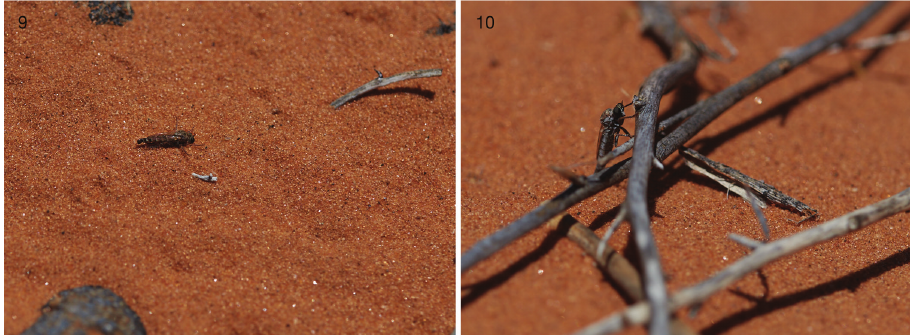
Figures 9–10. Photographs of M. gaiophanes sp. n. in nature on sand dune as in Figs 1–2: 9 ♂ resting on sand (note that pro-, mes- and metathoracic legs are held sideways and up so that tarsi do not touch sand, Mor- phbank #861774) 10 ♀ resting on dry vegetation just above ground (#861777). Photographs by T. Thorax : brown, postpronotal lobes and lateral scutum orange to light brown; pros- ternum grey pubescent, separated from proepisternum, square to rectangular in shape (straight dorsally); proepisternum grey pubescent, long yellowish macrosetose; cervical sclerite long yellowish setose; antepronotum grey pubescent, short yellowish setose and long yellowish macrosetose; postpronotum grey pubescent, long yellowish macrose- tose medially and laterally, long yellowish setose sub-laterally; postpronotal lope short and long yellowish macrosetose; pleuron grey pubescent; proepimeron short yellowish macrosetose anteriorly; anepisternum short yellowish macrosetose dorsally, supero- posteriorly short yellowish macrosetose (indistinguishable from other dorsal anepister- nal setation); anterior basalare short yellowish setose dorsally, posterior basalare asetose; anepimeron asetose, katepisternum predominantly asetose, postero-dorsally yellowish setose, katepimeron asetose, katatergite white setose and long yellowish macrosetose, meron + metanepisternum asetose, metakatepisternum asetose, metepimeron asetose, anatergite asetose; scutum predominantly grey pubescent, antero-sublaterally weakly grey pubescent (almost appearing apubescent), median longitudinal stripe and medio- laterally brown pubescent, scutum setation: short light brown setose, setae with small sockets, 2 npl setae, 1–2 spa setae, 2 pal setae, 3–4 long yellowish postsutural dc mac- rosetae, acr setae short brown presuturally and postsuturally, median posterior scutum (between dc setae) asetose; scutellum grey pubescent, ds sctl setae absent, ap sctl setae present, 6–8 long light brown macrosetae; postmetacoxal area entirely membranous. Leg : light brown to brown, apubescent, all setae circular in cross section; pro coxa dark brown proximally, light brown distally, grey pubescent, white setose and macro- setose; pro femur brown, short white setose, yellowish macrosetose: 1 anterior proxi- mally, 1 postero-dorsal distally, 1 dorsal distally; pro tibia light brown to brown, short white setose, yellowish macrosetose: 4 in 1 antero-dorsal row, 4 in 1 dorsal row, 2 in 1 posterior row, 3 in 1 postero-ventral row, distal tip with 5–6 long yellowish macro- setae; mes coxa brown, grey pubescent, white setose and yellowish macrosetose; mes femur brown, short white setose, yellowish macrosetose: 1 antero-dorsal proximally,